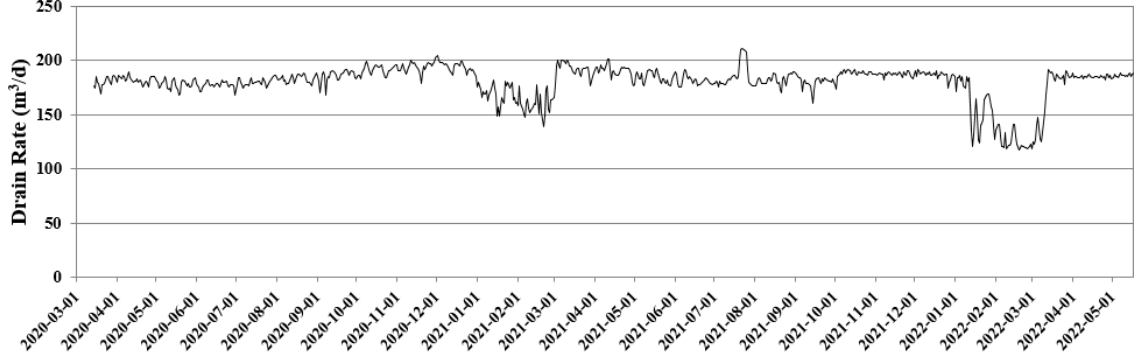
Figure 9. Water drain rates from existing pond.